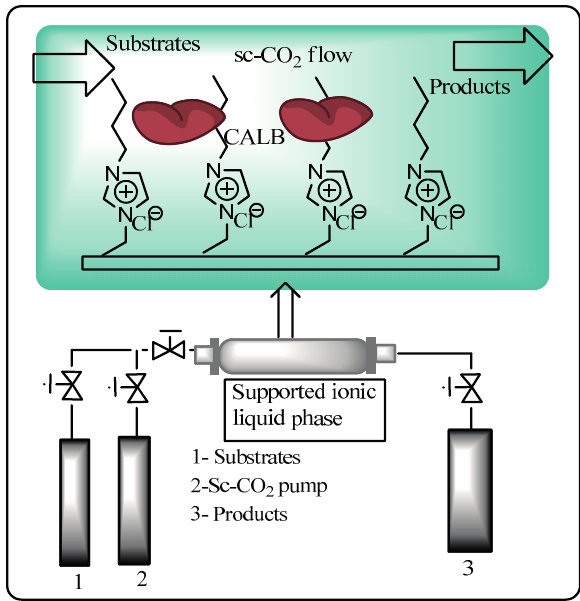
Figure 6. Continuous flow reactor setup employing CALB supported on an immobilized ionic liquid phase and sc-CO 2 as a mobile phase